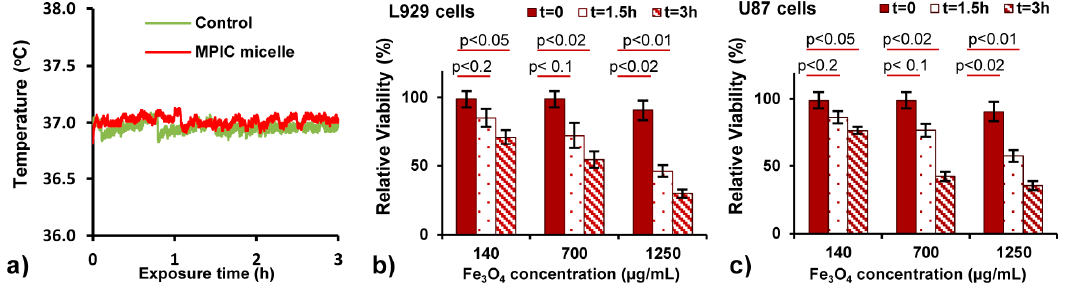
Figure 5. ( a ) Temperature variation in suspensions of control cells and cells incubated with MPIC micelles during exposure to an alternating magnetic field (755 kHz, 10.2 kA · m − 1 ). Viability of L929 ( b ) and U87 ( c ) cells determined by the MTS assay after 24 h of incubation with MPIC micelles G1@Fe 3 O 4 @PAA 27 - b -PHEA 260 f = 0.5, with or without exposure to the high frequency alternating magnetic field. Cell viability is expressed as the mean value relatively to untreated cells (control 100%; probability p was calculated by the two tail Student’s t -test).